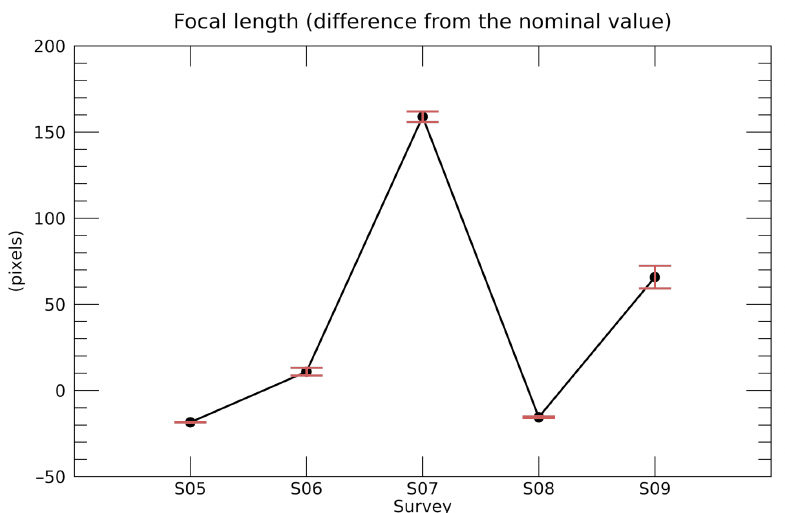
Figure 7. Focal length deviation from the nominal value (in pixel units) computed for the different surveys in the self-calibration procedure.